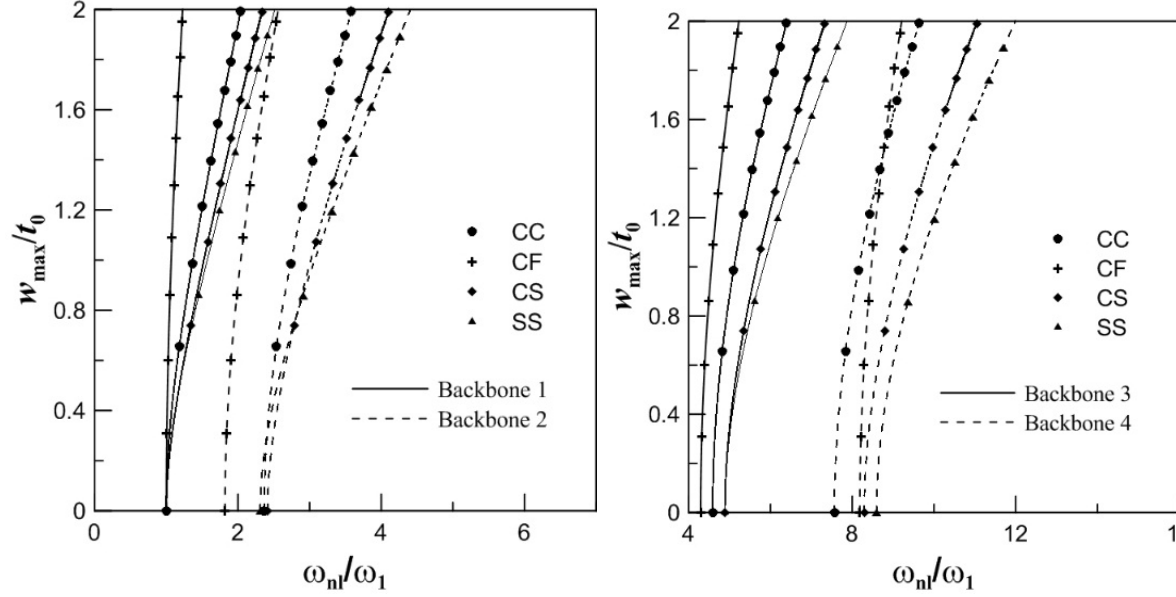
Figure 12: Backbone curves of parabolic taper AFG material (︀ E ( ξ ) = E 0 (1 + ξ ) , ρ ( ξ ) = ρ 0 (︀ 1 + ξ + ξ 2 )︀)︀ for CC, CF, CS, SS boundary condi- tion at α = 0.4 and K = 10,000 N/m.